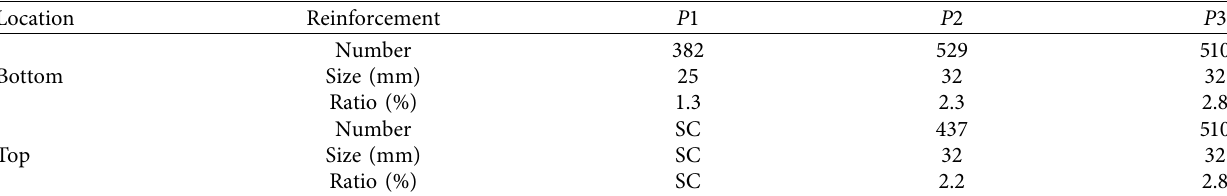
Table 4: Suggested longitudinal reinforcements of piers.